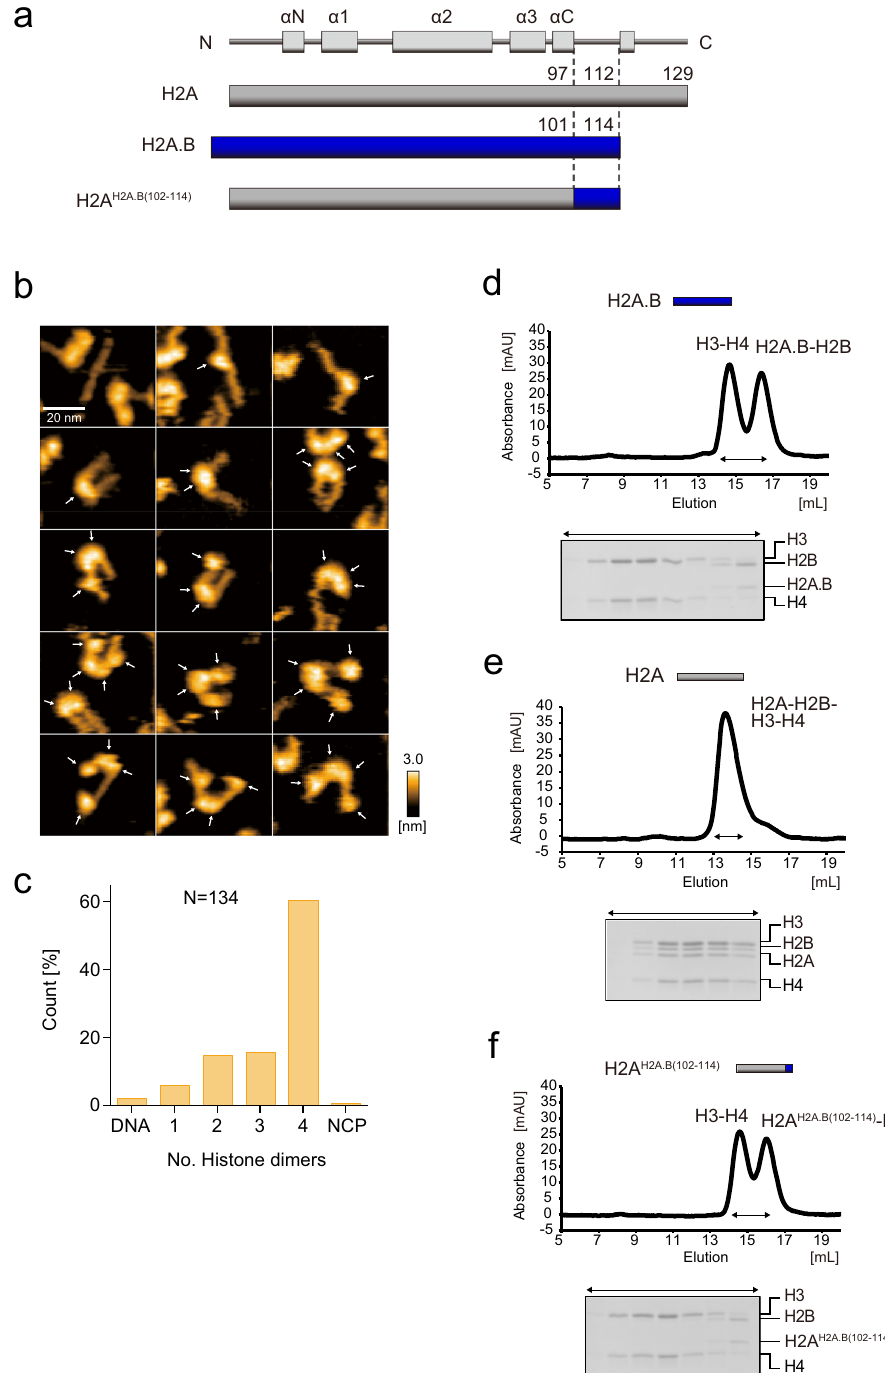
Fig. 5 HS-AFM observation and histone octamer formation assay of the H2A H2A.B(102 – 114) NCP. a Graphical representation of the chimeric protein used in the HS-AFM observations shown in ( b , c ) and the histone octamer formation assay shown in ( d – f ). b Initial HS-AFM images of the H2A H2A.B(102 – 114) NCP. Individual particles are presented in the panels. White arrows indicate possible histone dimers. Scale bars are 20 nm. c The numbers of histone dimers in individual particles were counted and plotted. N indicates the total number of the counted particles. The source data for HS-AFM analysis are shown in Supplementary Data 1. d – f The H3-H4 tetramers were mixed with the H2A.B-H2B dimer ( d ), the H2A-H2B dimer ( e ), or the H2A H2A.B(102 – 114) - H2B dimer ( f ), and incubated in the presence of 2 M NaCl at 37 °C for 30 min. After the incubation, the samples were subjected to chromatography on a Superdex 200 10/300 GL column. Histone compositions of the peak fractions were analyzed by 18% SDS-PAGE with CBB staining. Reproducibility is con fi rmed by two independent experiments, and the results are presented in Supplementary Fig. 7. The uncropped gel images are shown in Supplementary Fig.